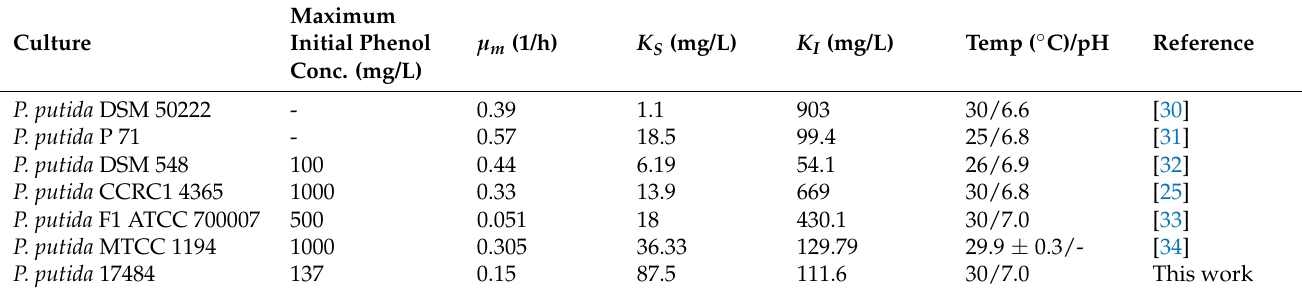
Table 1. Kinetic constants of Haldane kinetics for phenol biodegradation with P. putida